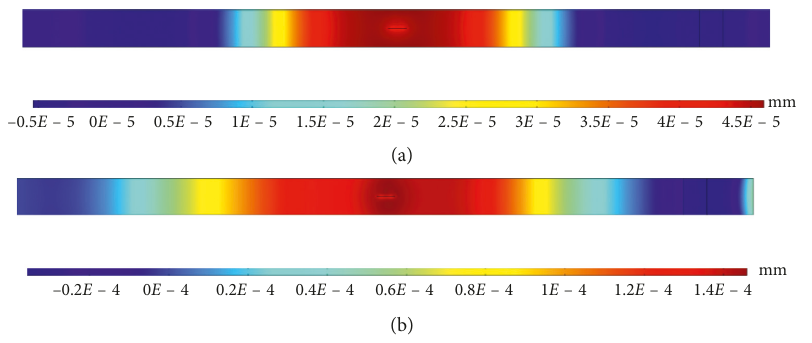
Figure 6: Displacement of bare ABH beam at different times: (a) t � 1.1 e − 4s; (b) t � 2.8 e −